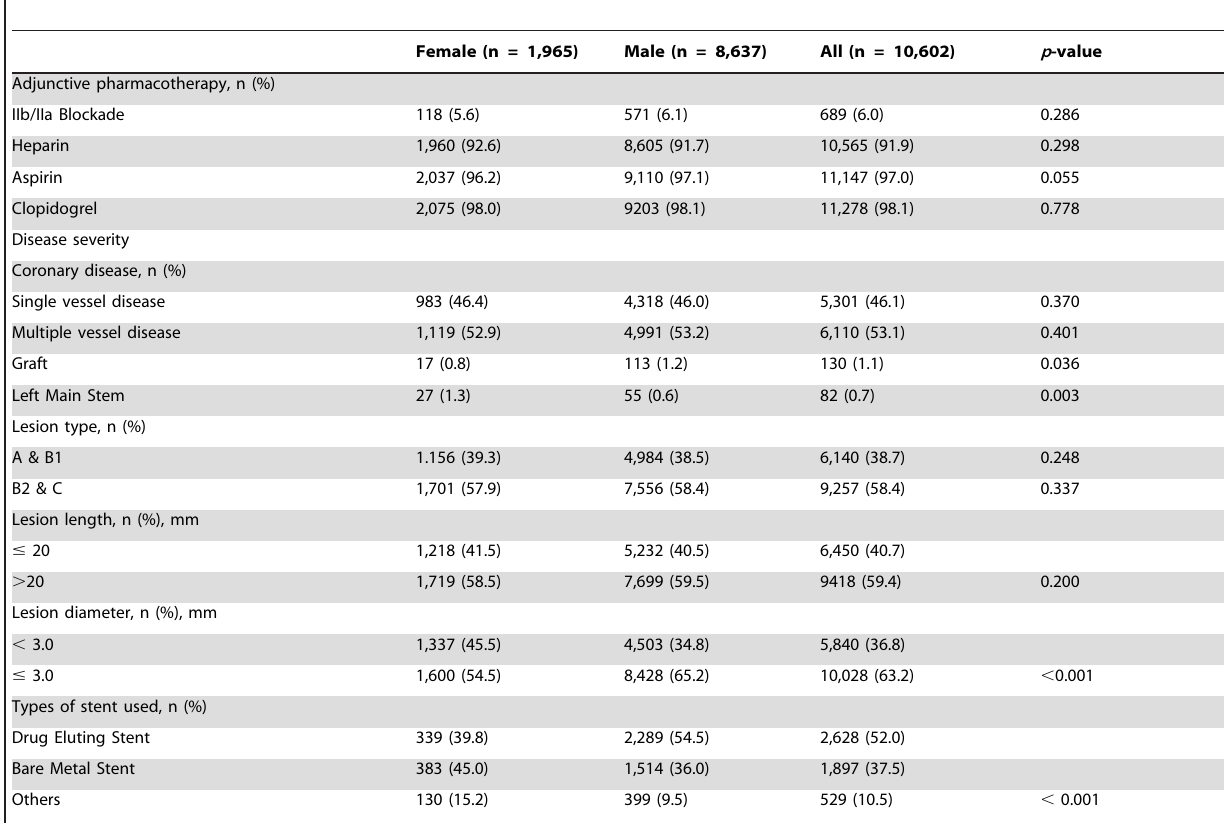
Table 3. The use of PCI adjunct and angiographic disease severity by